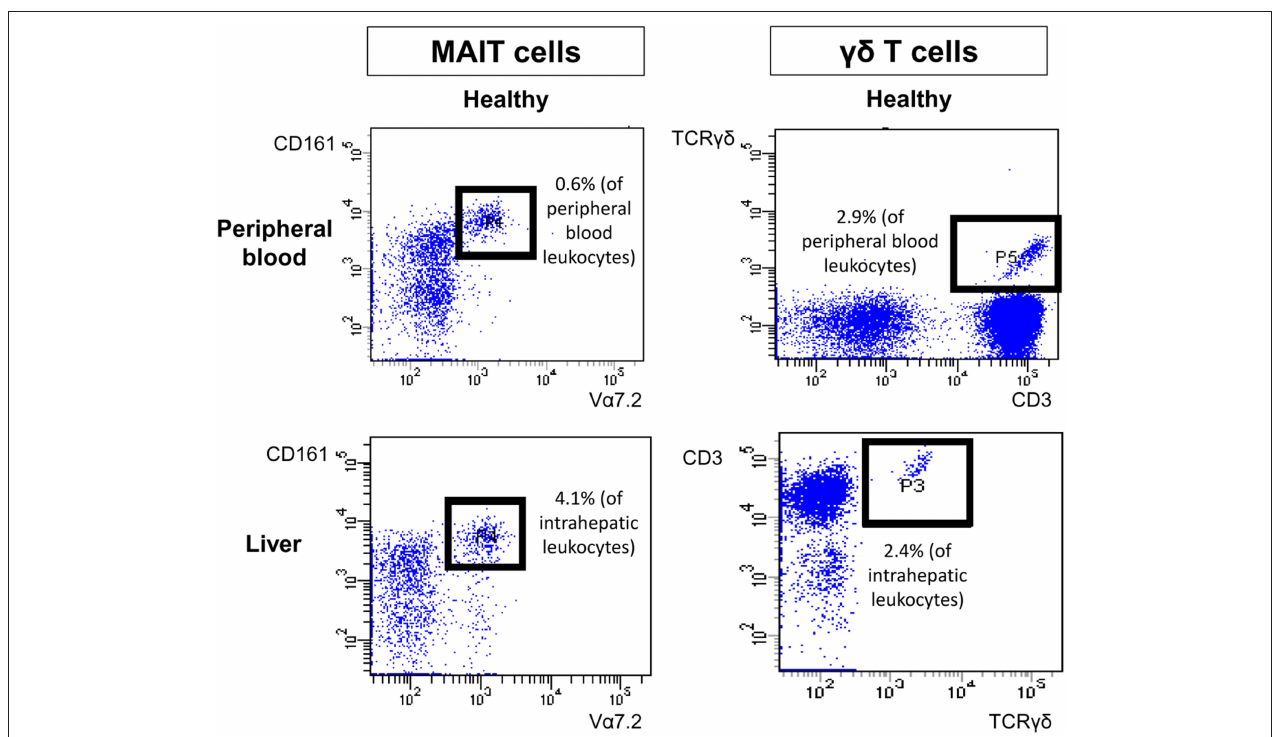
FIGURE 4 | Exemplary flow cytometric stainings of peripheral and intrahepatic MAIT and γδ T cells. Representative flow cytometric stainings of peripheral blood (upper row) and intrahepatic (lower row) MAIT cells (left) and γδ T cells (right) of a healthy individual are shown.